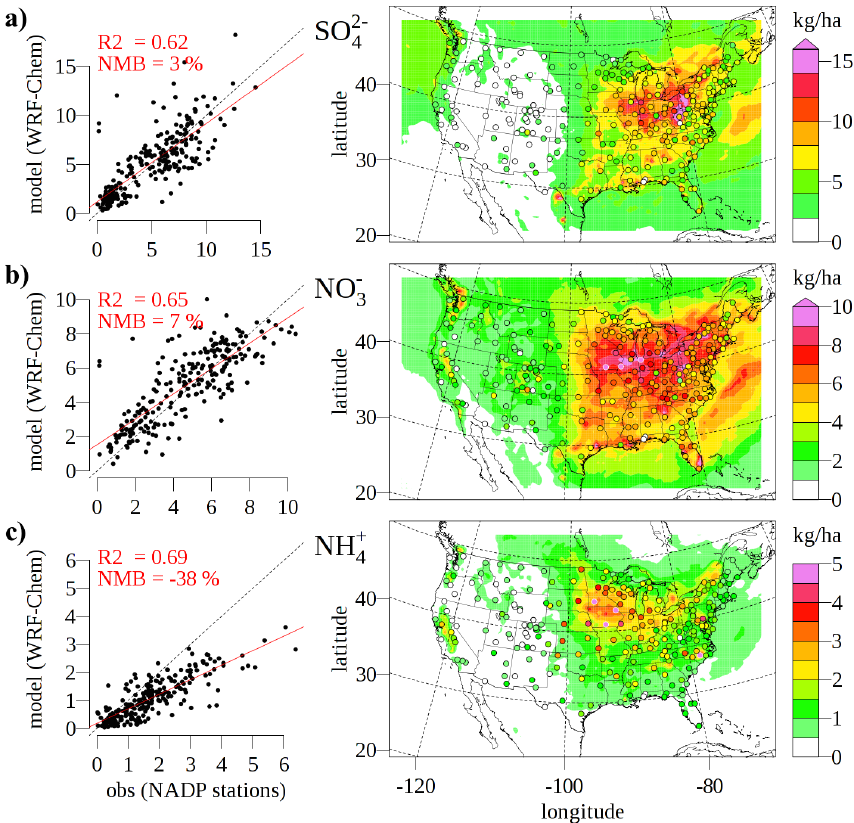
Figure 3. Year 2010 accumulated wet deposition of inorganic ions (a) SO 2 − and as predicted by WRF-Chem (model). The data are represented as maps (right column), with stations as circles color-coded by measured amount, and as scatterplots (left column) with R 2 as the squared Pearson correlation coefficient, and NMB as the normalized mean bias (NMB = (cid:54)( model − obs )/(cid:54) obs ×